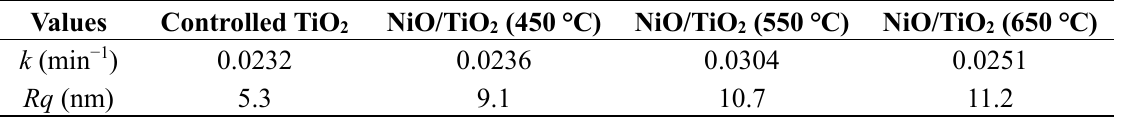
Table 1. Rate constant ( k ) and root-mean-square surface roughness ( R q ) of the controlled TiO 2 film and the NiO/TiO 2 nanocomposite structure treated by the RTA process at temperatures of 450 °C, 550 °C, and 650 °C, respectively.